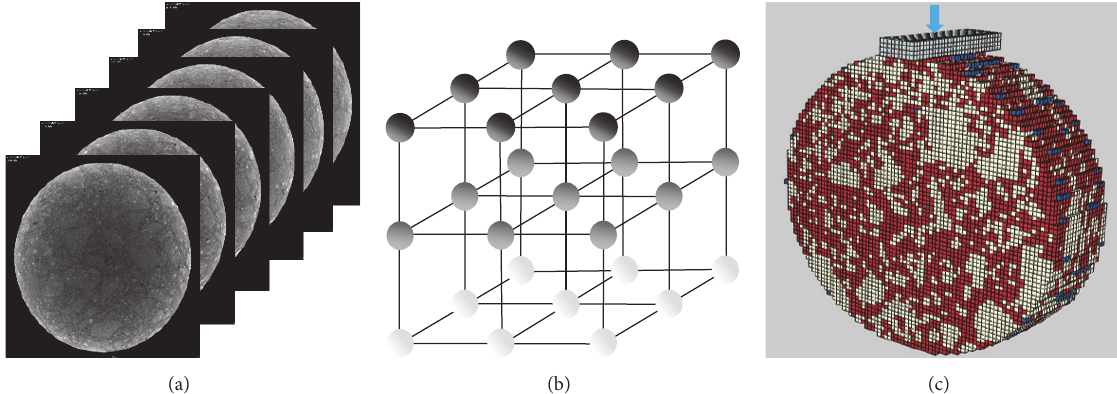
Figure 3: Numerical model generation of asphalt mixture, (a) series of consecutive CT images, (b) gray unit net of multiple CT images, and (c) voxel-based numerical model of asphalt